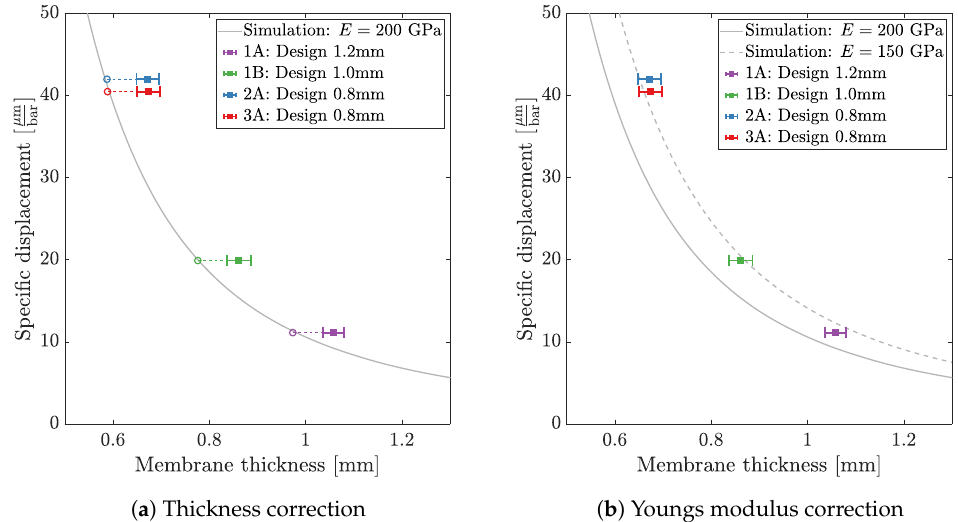
Figure 7. The specific displacement of each membrane thicker then 0.6mm in function of the membrane thickness is depicted on both charts. On the left pane, a thickness correction method is shown, which consists of a static thickness which is subtracted from the membrane thickness. The gray line depicts the FES, and the circles depict a thickness correction of 85µm. On the right pane a Young’s modulus correction is depicted, which consists of a reduction of the Young’s modulus used in the simulation. The gray full line depicts again the FES with a Young’s modulus of 200GPa, whereas the dotted line depicts a FES with a Young’s modulus of 150GPa. The thickness correction appears to be slightly more accurate in predicting the specific displacement than the Young’s modulus correction; however, the Young’s modulus correction is easier to